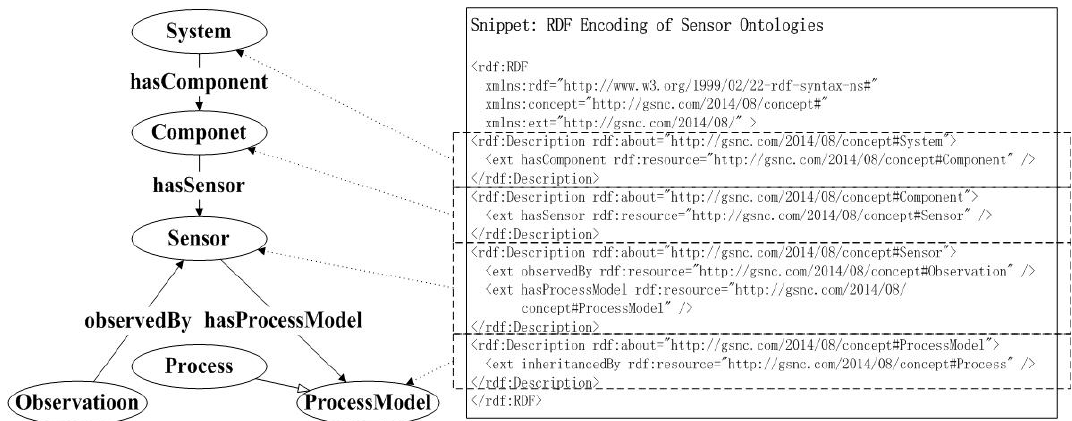
Figure 2. RDF/XML Encoding of Sensor Ontologies.